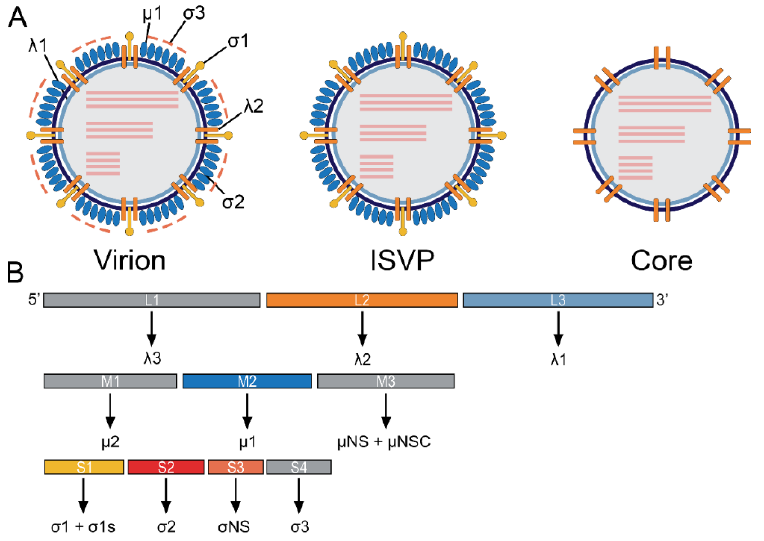
Figure 1. ReoV structure and genome organization. ( A ) Schematic depiction of the mature virion, containing all virally encoded proteins ( left ); the ISVP, a replication intermediate which has shed the σ 3 protein ( middle ); and the viral core, lacking σ 3, σ 1, and μ 1 ( right ). Viral proteins are indicated by black lines. Viral dsRNA genome segments are portrayed as pink lines. ( B ) ReoV genome comprises 10 dsRNA segments, depicted as rectangles. The proteins encoded by each segment are portrayed below.